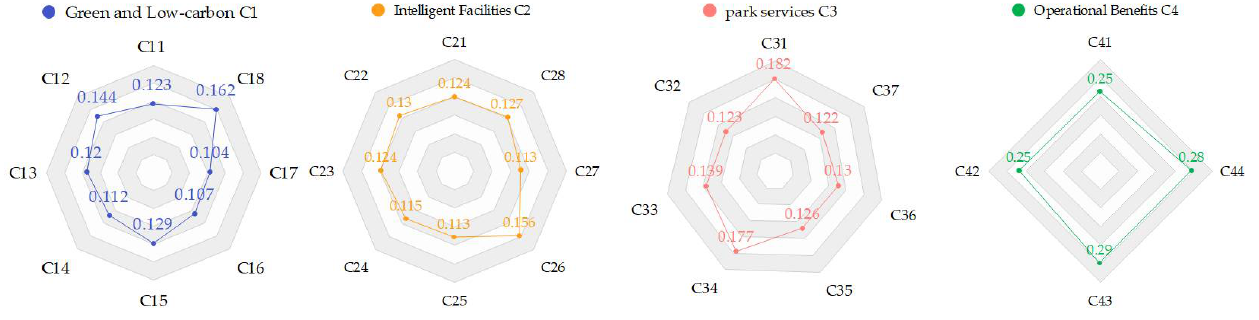
Figure 6. Composition of each dimension of the intelligence level of SIPs.